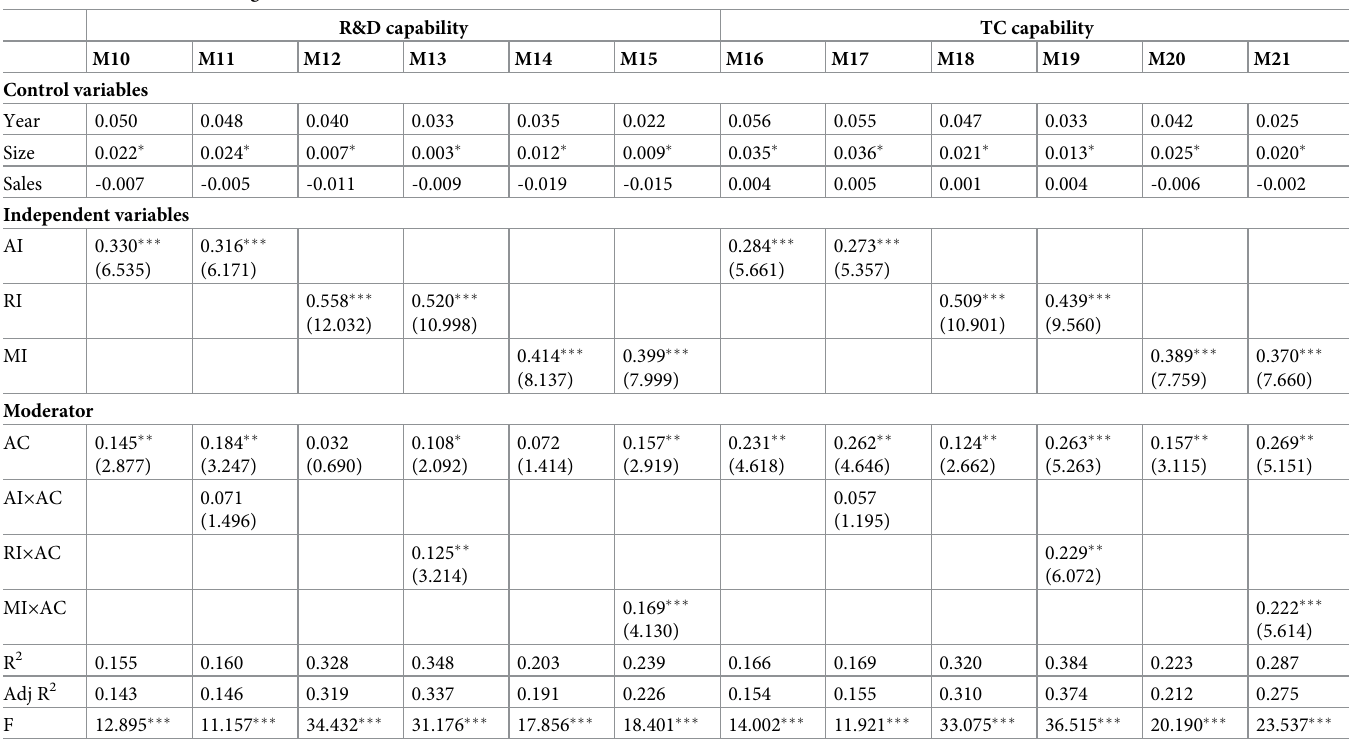
Table 6. Results of moderating